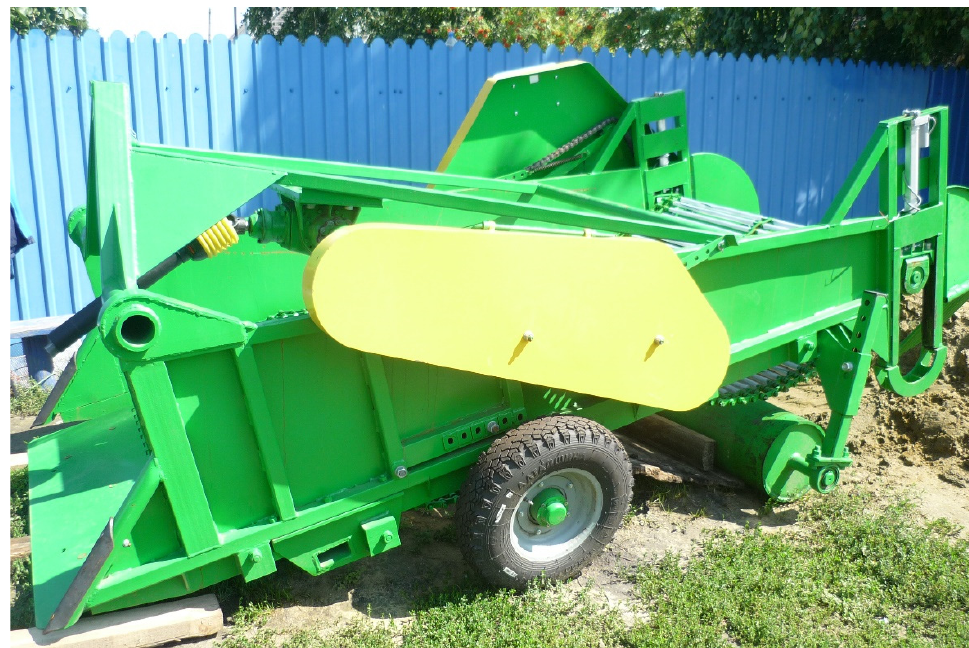
Figure 5. General view of the harvesting machine for root crops and onions, equipped with a separating rod elevator with an adjustable blade inclination angle and a receiving plowshare for digging/picking up root crops and bulbs.